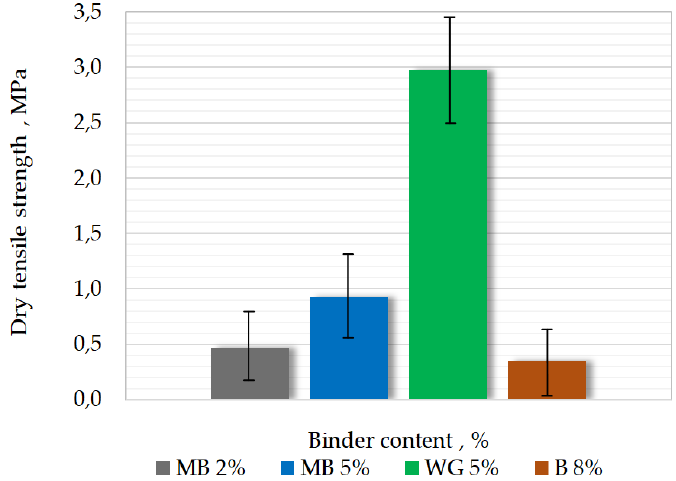
Figure 9. Results of dry tensile strength measurements of different molding sands.